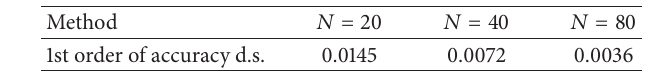
Table 3: Error analysis for 𝑝(𝑥) .